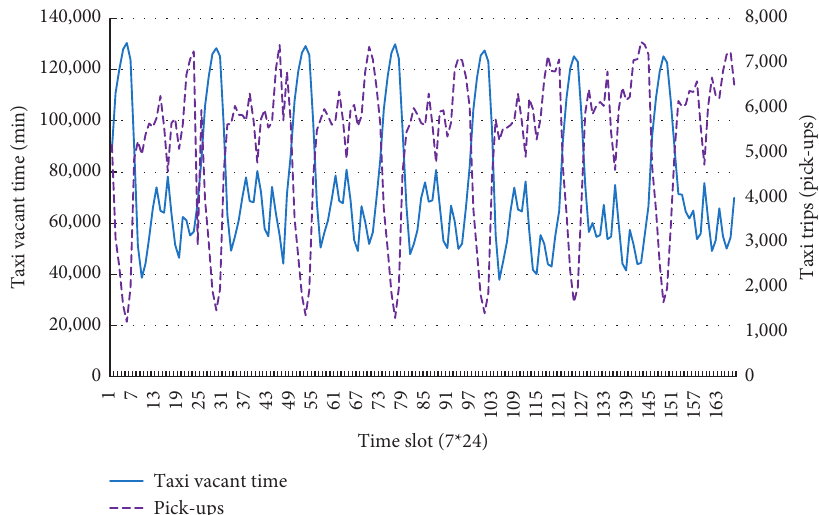
Figure 2: Total taxi vacant time and total pick-ups per hour for 7 days.